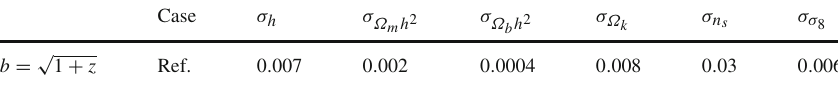
Table 7 Numerical values for marginalized 1 σ constraints on cosmological parameters using constant γ and w